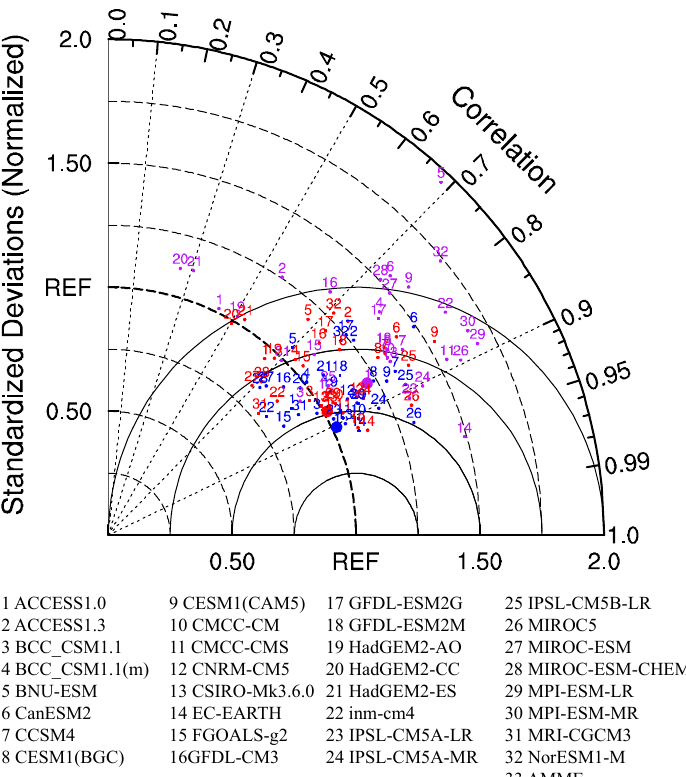
Figure 3. Taylor diagrams of three extreme rainfall indices including R95p (red dot), RX5d (blue dot), and R10mm (purple dot) over Northern China. Small dots represent 32 CMIP5 climate models (Table 1) and large dots denote the CMIP5 multi-model ensemble mean.